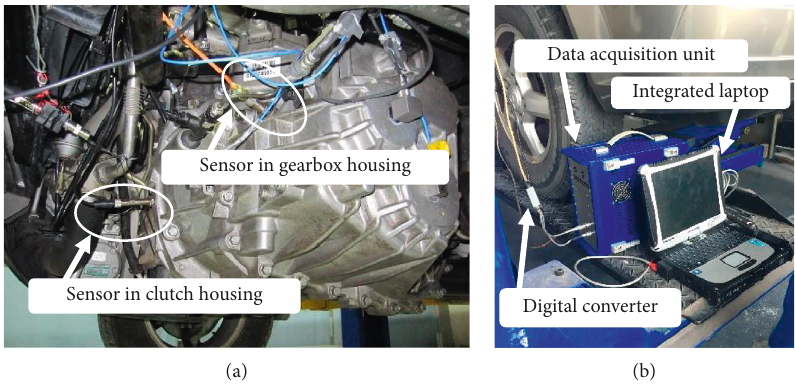
Figure 6: (a) Sensor installation and (b) testing site.